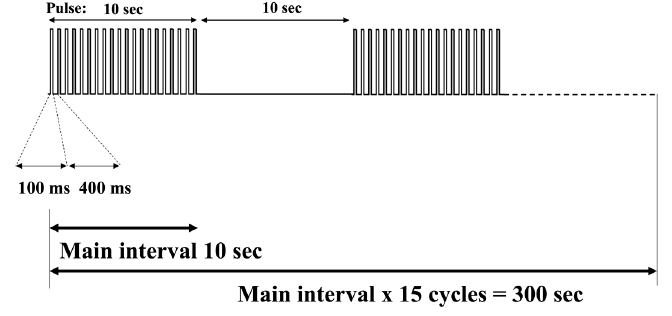
Figure 5. Stimulation duration consisted of 15 consecutive cycles amounting to 5 min of total stim- ulation. Each cycle consisted of two parts. The first half included the pulsing light, with each pulse consisting of 100 ms of light and 400 ms of no light. This is repeated 20 times for a total of 10 sec. The second half consisted of no stimulation, meaning no pulsing light. This lasted for 10 s, combining for a total of 20 s per cycle.